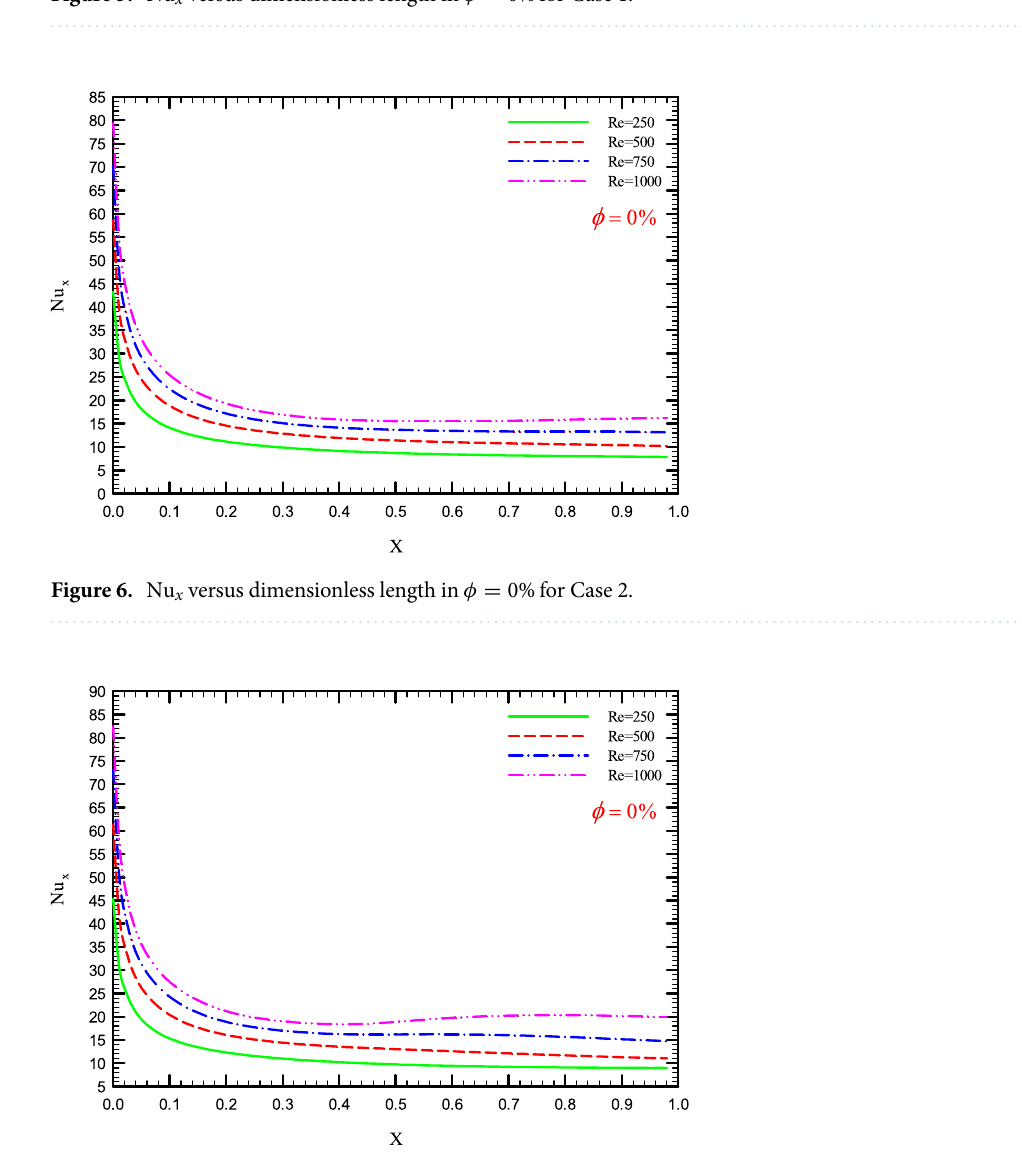
Figure 5. Nu x versus dimensionless length in φ = 0% for Case 1.